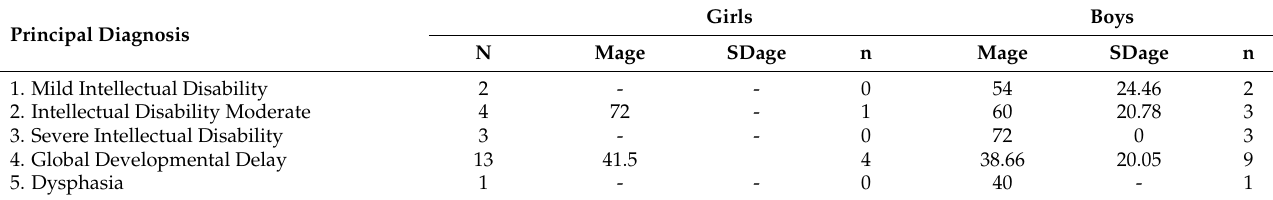
Table 1. Description of the sample